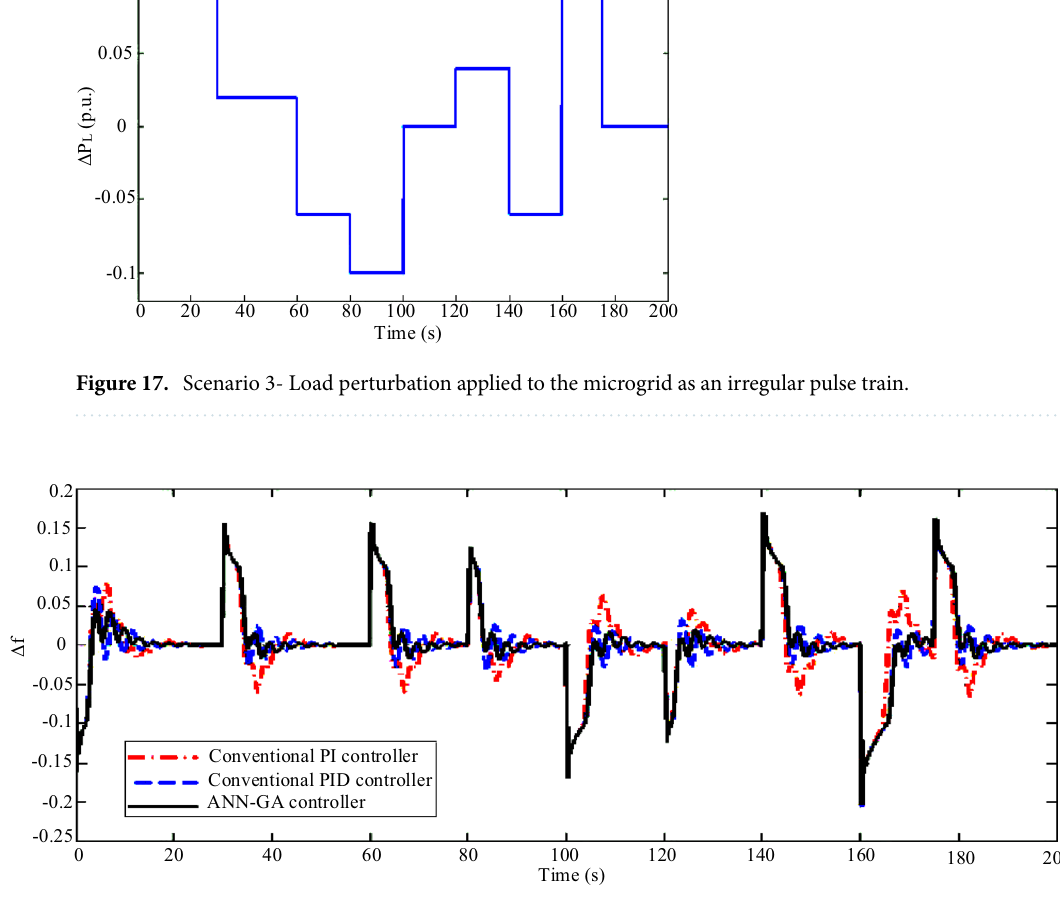
Figure 18. Scenario 3- Microgrid frequency response to an irregular pulse